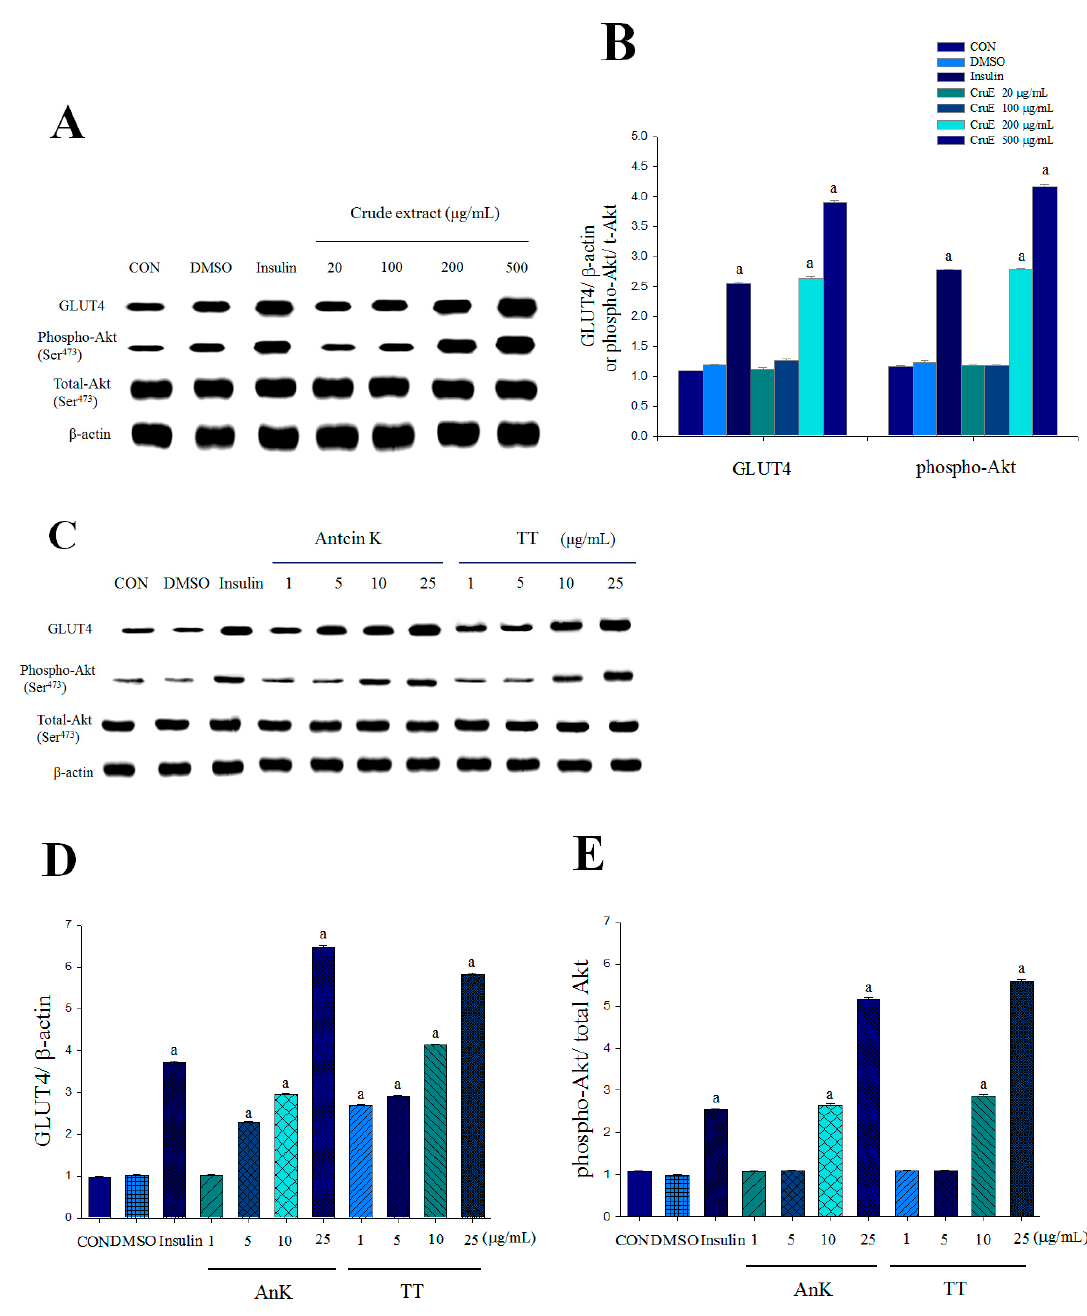
Figure 2. Effects of MeOH crude extract (CruE) and comparative effects of antcin K (AnK) and dehydroeburicoic acid (TT) on membrane glucose transporter 4 (GLUT4) and phospho-Akt/total-Akt in vitro : ( A , C ) representative blots in C2C12 myoblasts cells; ( B , D , E ) quantification of the GLUT4 protein contents and the ratio of phospho-Akt to total Akt. C2C12 skeletal myoblasts cells were treated with MeOH crude extract or compounds as described under Material and Methods, and equal amounts of lysates were resolved by SDS-PAGE and blotted for GLUT4, Akt, and phospho-Akt (Ser 473 ). All values are means ± SE ( n = 3 ). a p < 0.001 compared with the control group.